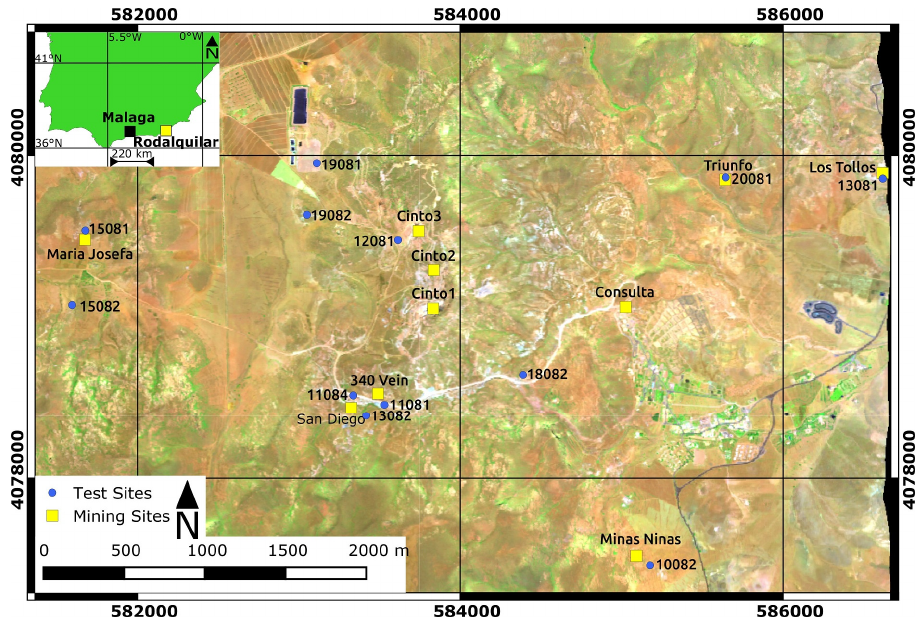
Figure 1. HyMAP composite of the main part of the Rodalquilar caldera (R: 2225 nm, G: 911 nm, B: 556 nm), with the locations of the former mining sites in the greater Rodalquilar area. This band combination highlights vegetation in bright green colors.